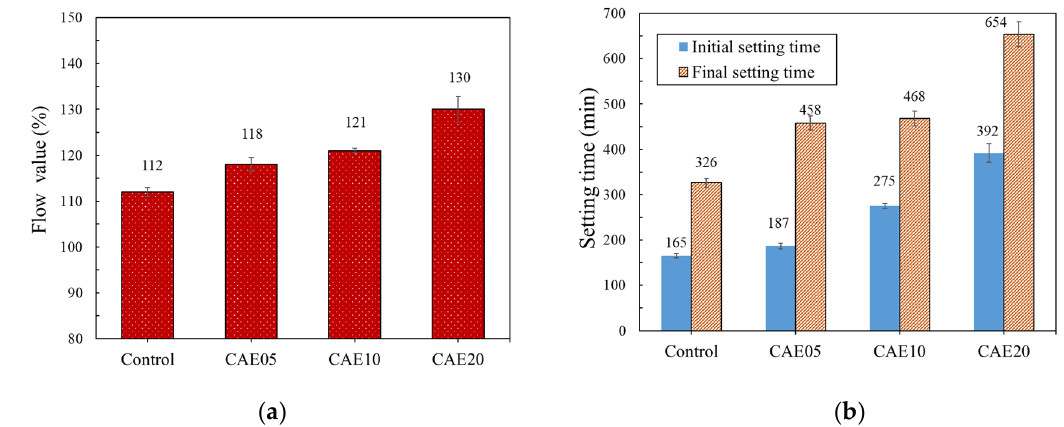
Figure 5. Results for the hybrid alkali-activated mortars with different CAE contents in terms of ( a ) setting times and ( b ) flow values.